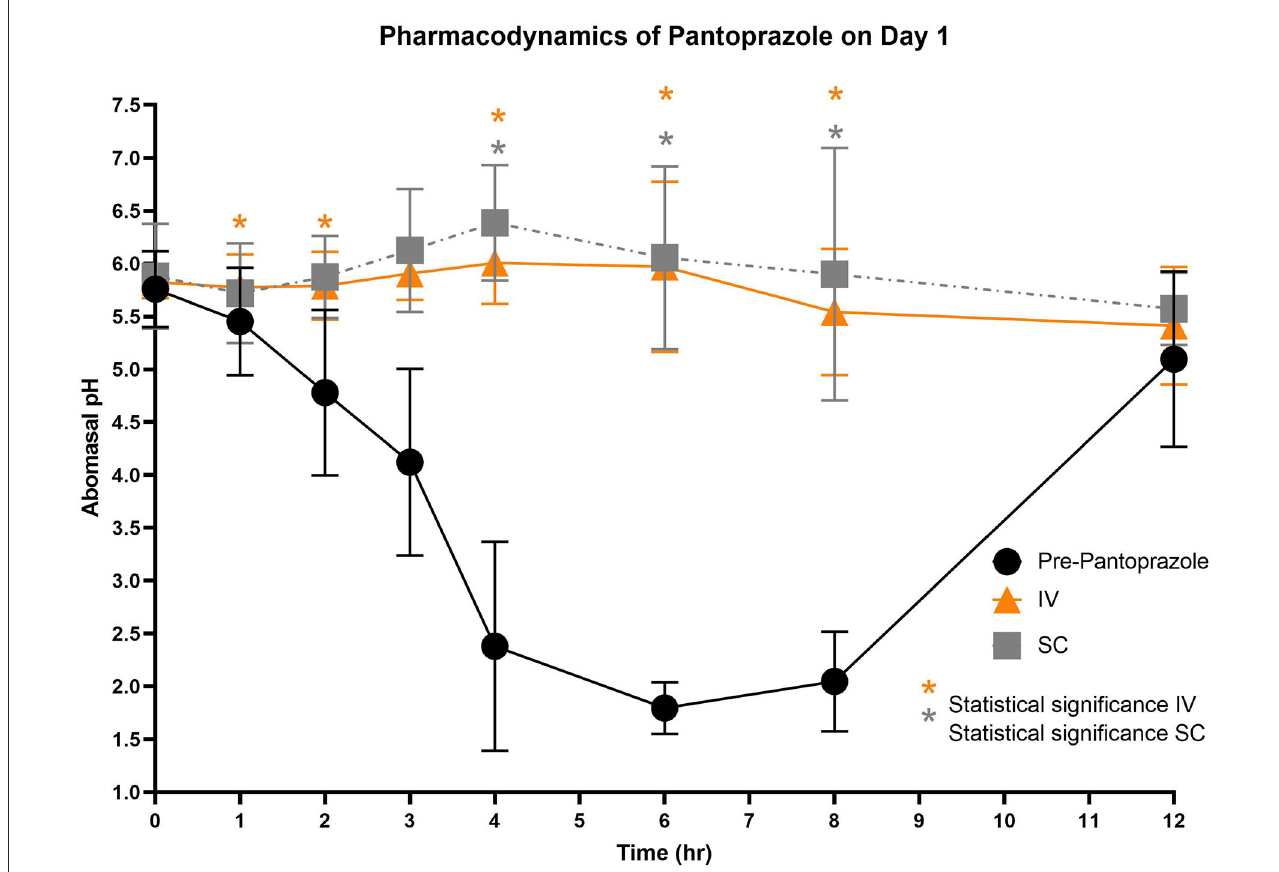
FIGURE3 Comparison of abomasal pH over time between control, IV, and SC treatment groups on Day 1. Black circles, pH pre-pantoprazole administration; Orange triangles, pH after IV pantoprazole administration; Gray square, pH after SC administration. Statistical significance ( P < 0.05) noted with